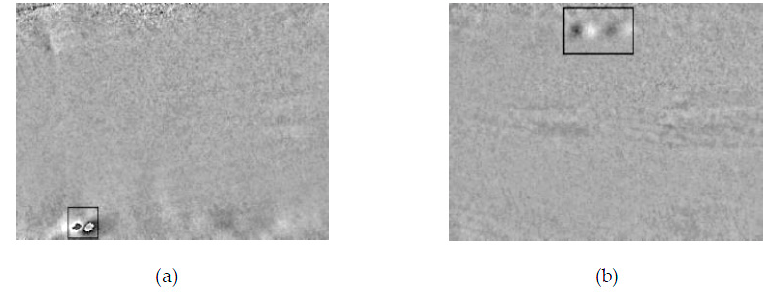
Figure 2 . Cont. Figure 2.